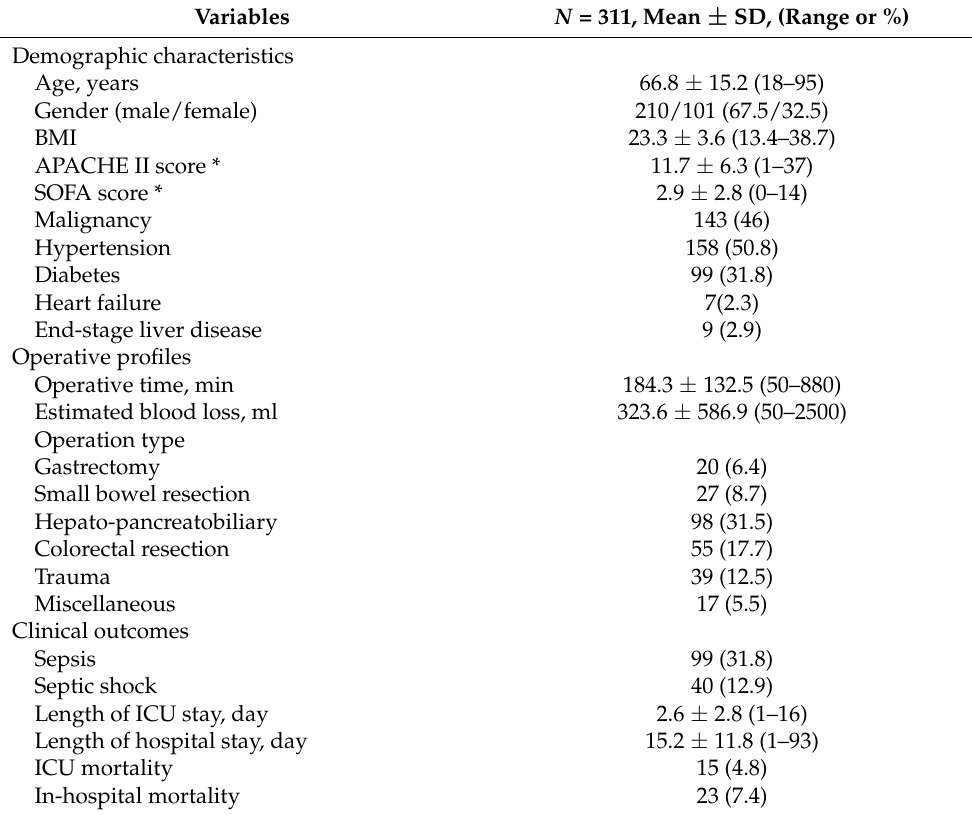
Table 2. Demographic characteristics and clinical outcomes of study